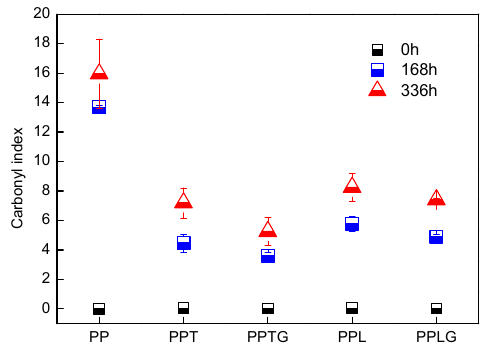
Figure 8. Carbonyl index of PP and PP/polyphenol blends over exposure time.